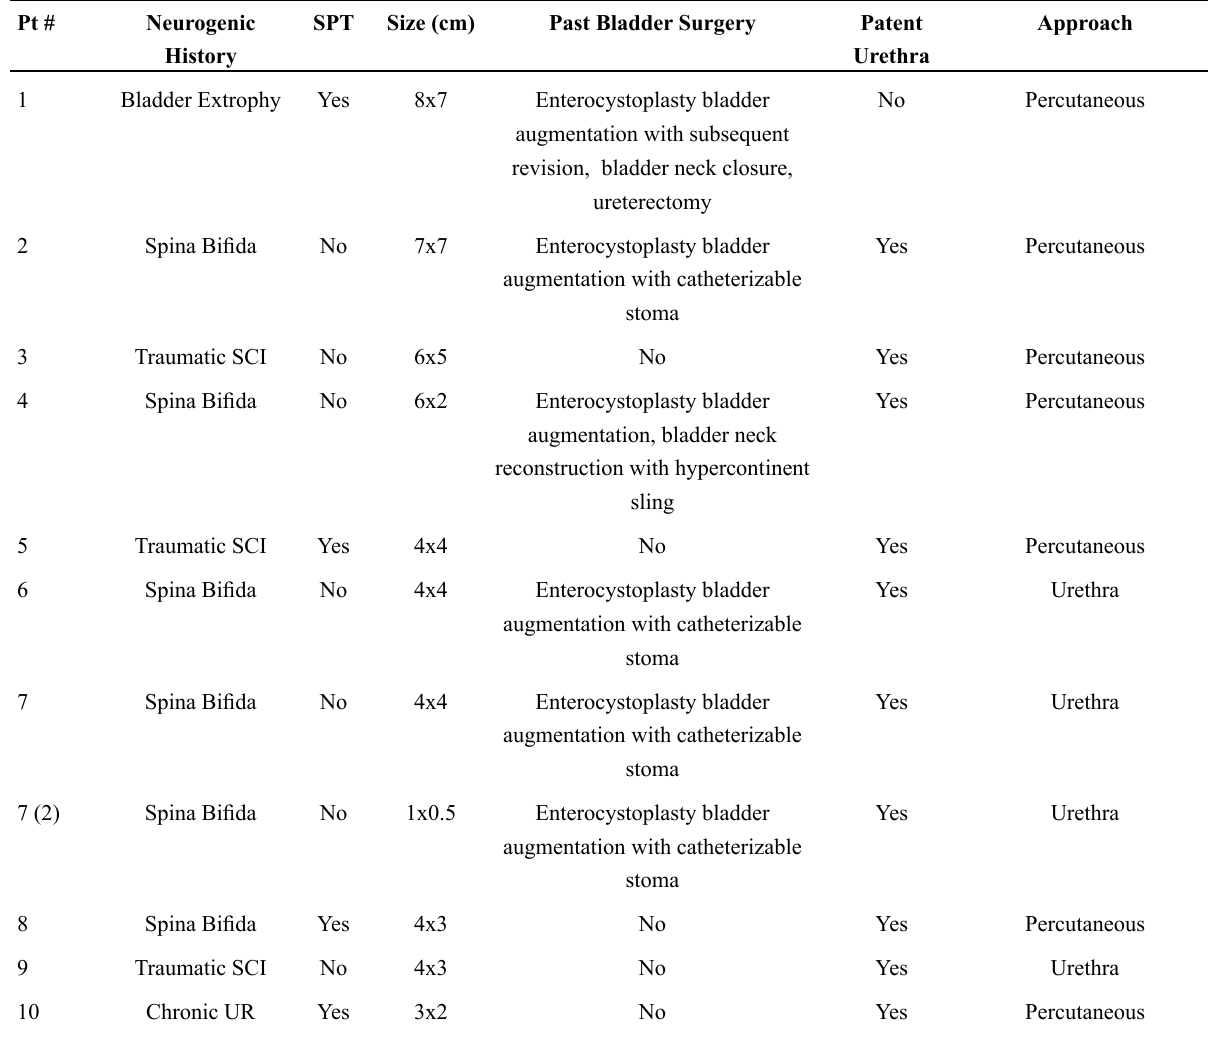
Table 1 - Patient